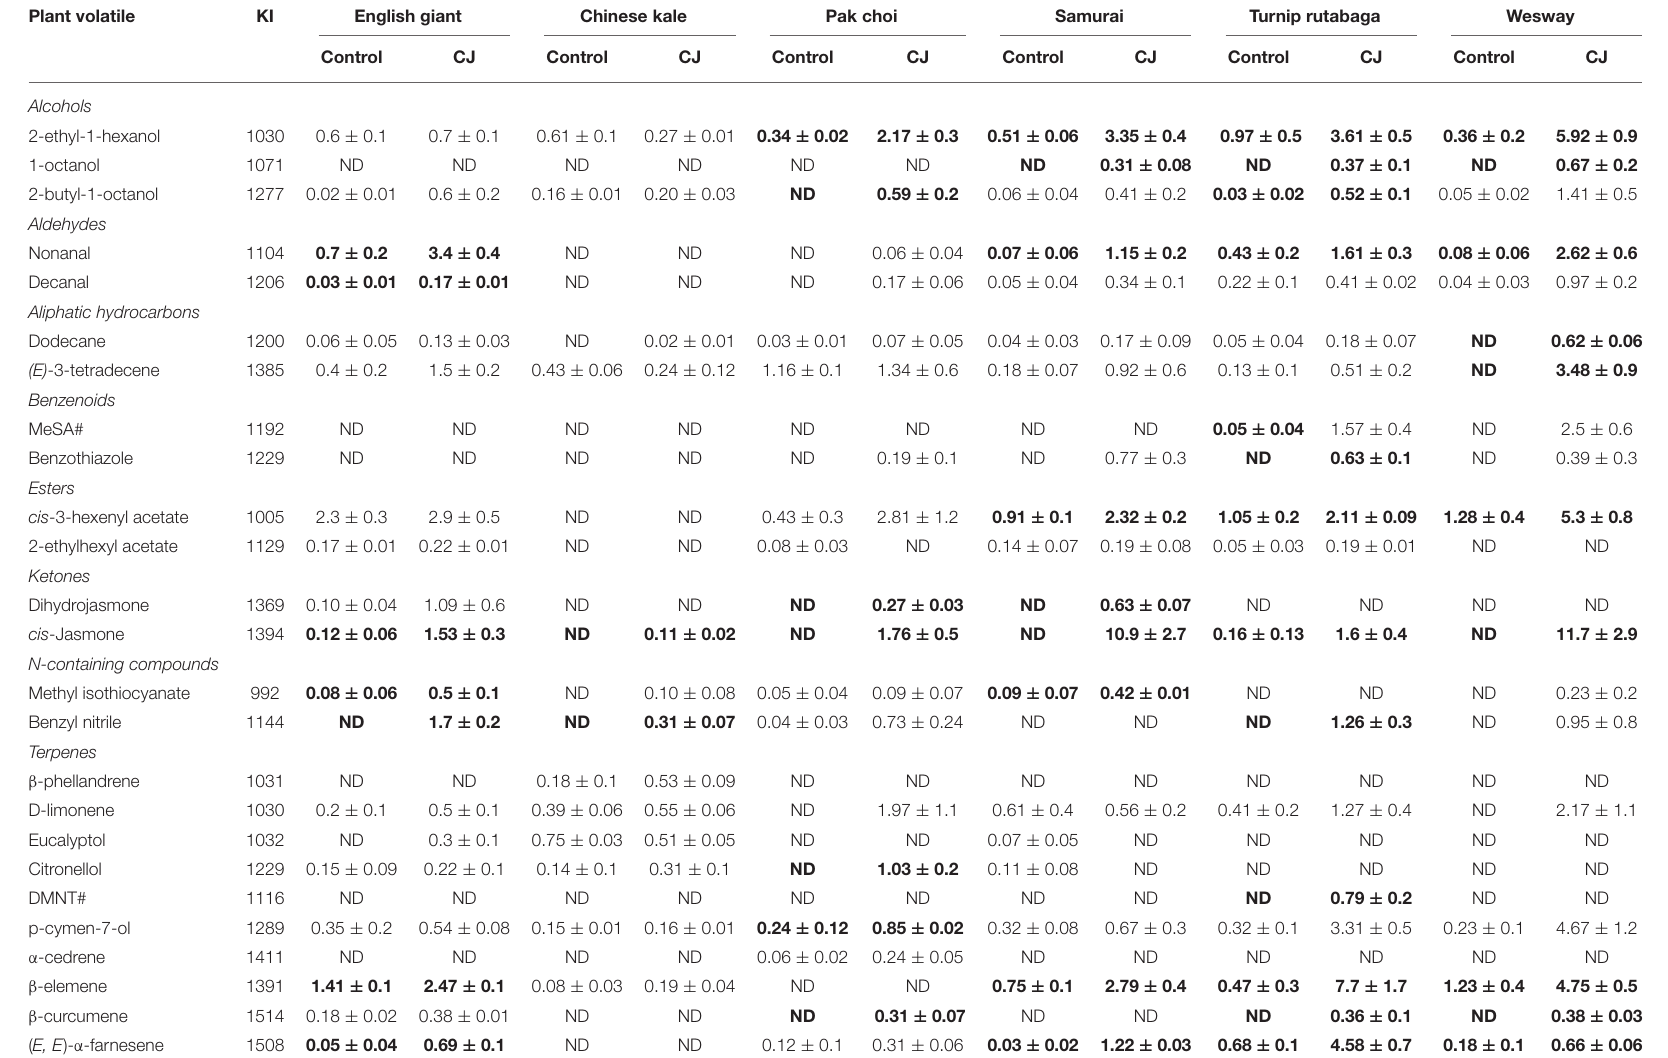
TABLE 1 | Emission (in ng; mean ± SE; n = 3) of volatiles released by cis -jasmone treated (CJ) and non-treated (Control) plants a . Plant volatile